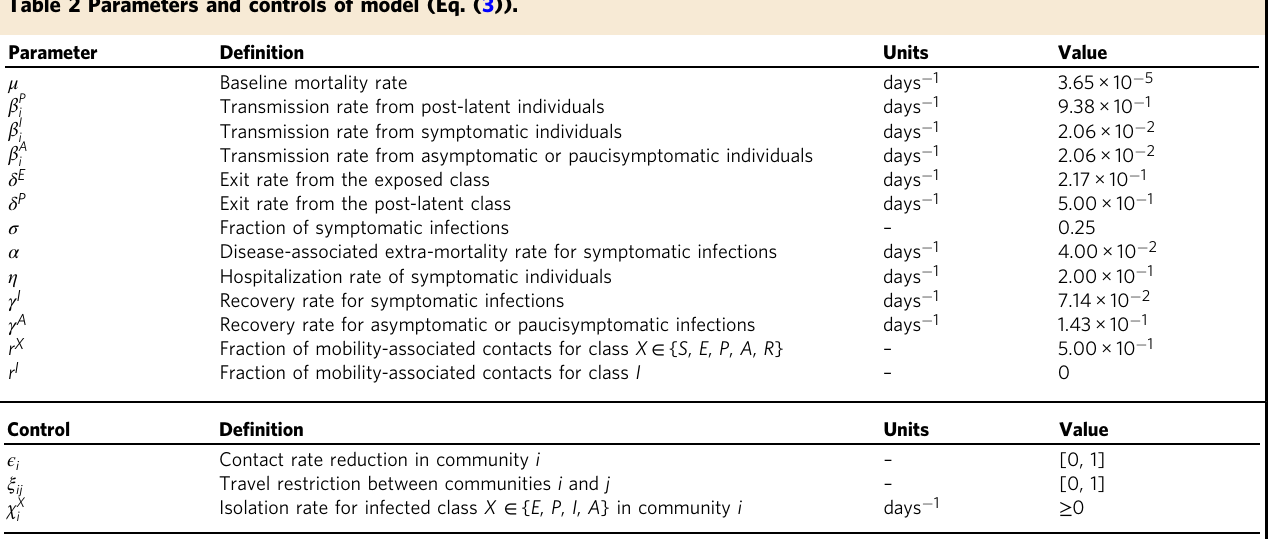
Parameter values (median estimates at the beginning of the epidemic, when no controls were assumed to be in place) are taken from Bertuzzo et al. 14 . Control values are left free to vary within suitable